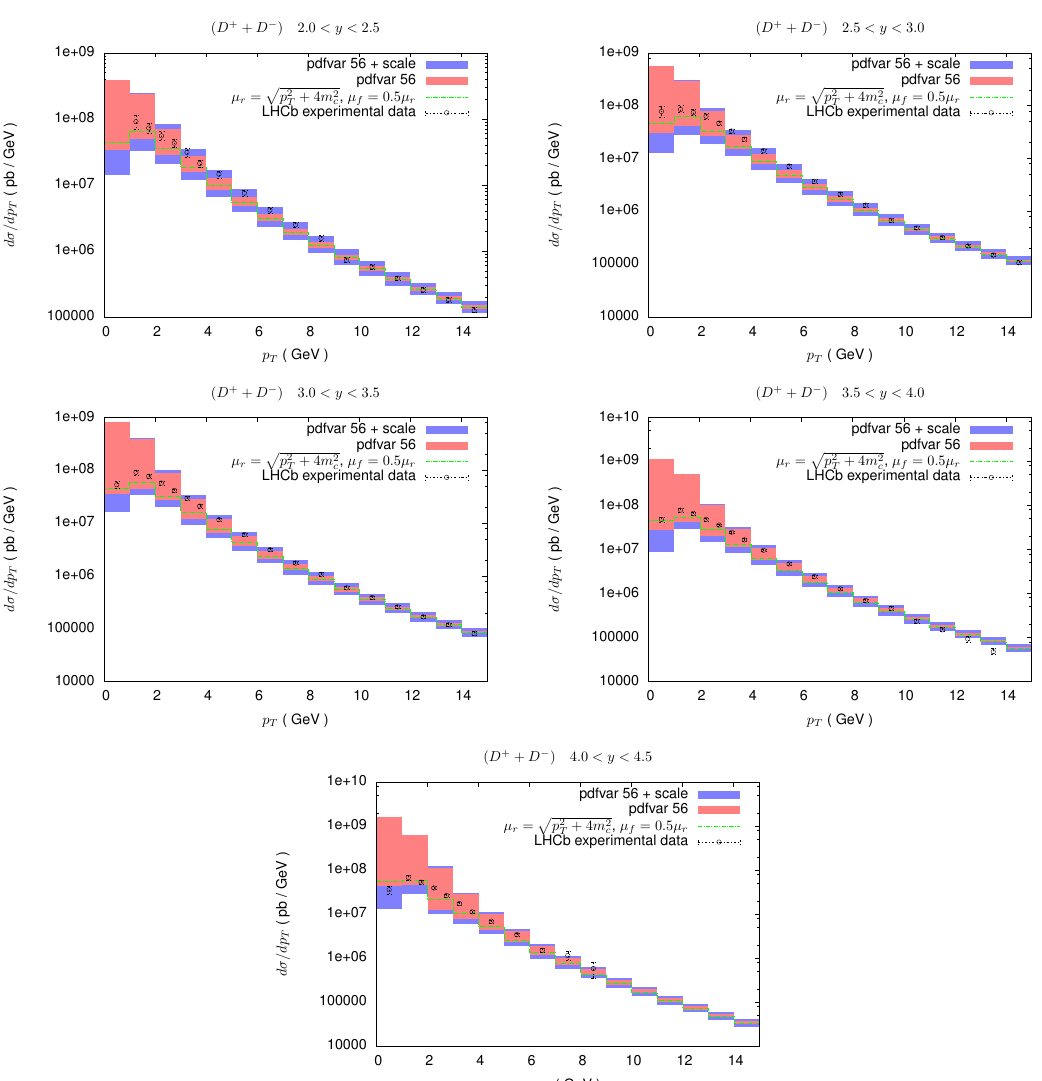
Figure 19 . Our GM-VFNS predictions for ( D + + D (cid:0) ) transverse-momentum distributions in pp collisions at p S = 13 TeV vs. LHCb experimental data of ref. [44]. Each panel corresponds to a di(cid:11)erent rapidity bin in the interval 2 < y < 4.5. The PDF uncertainties and the scale plus PDF uncertainties are computed as in (cid:12)gure